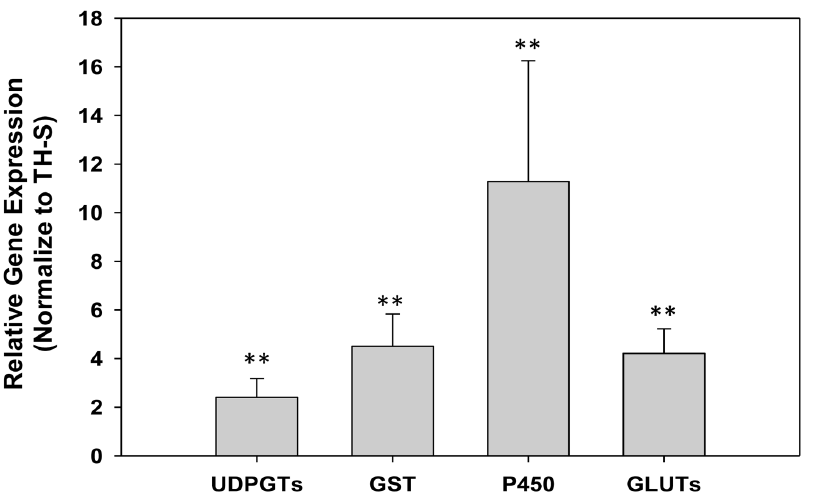
Figure 5. Venn diagram summarizing the proportion of proteins and genes significantly expressed between thiamethoxam resistance and susceptible B.tabaci . Differentially expressed transcripts and peptides are represented in respective circles. The overlapping region denotes specific transcripts with their corresponding peptides.